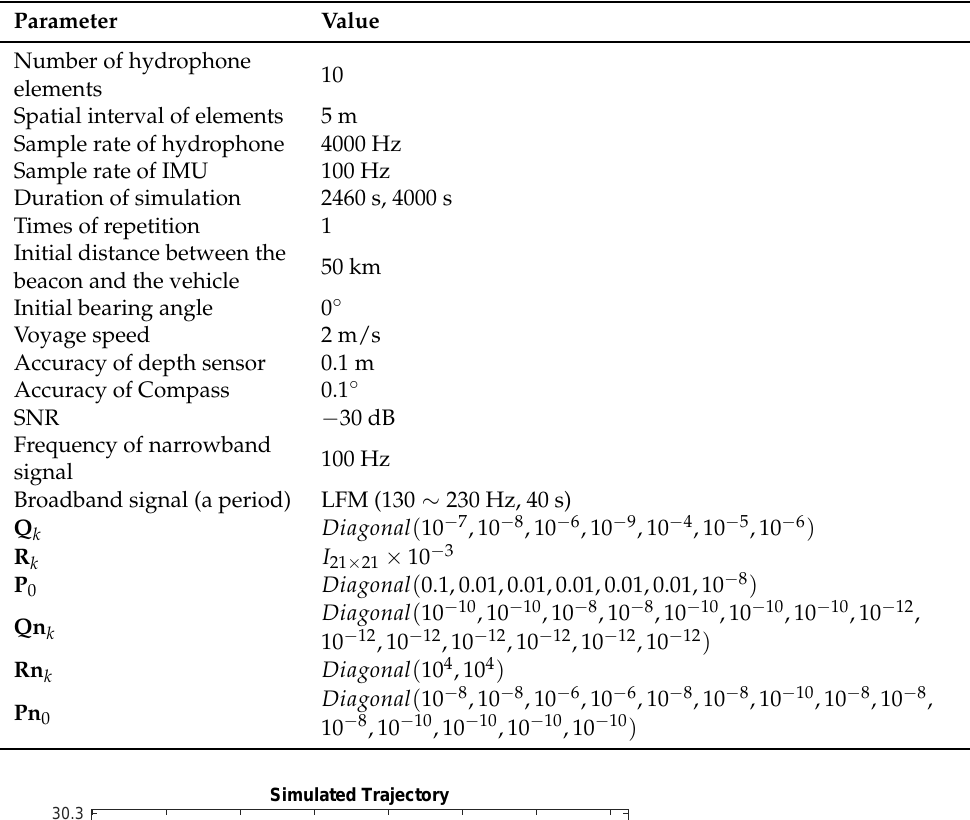
Table 6. Simulation configuration in performance comparison.